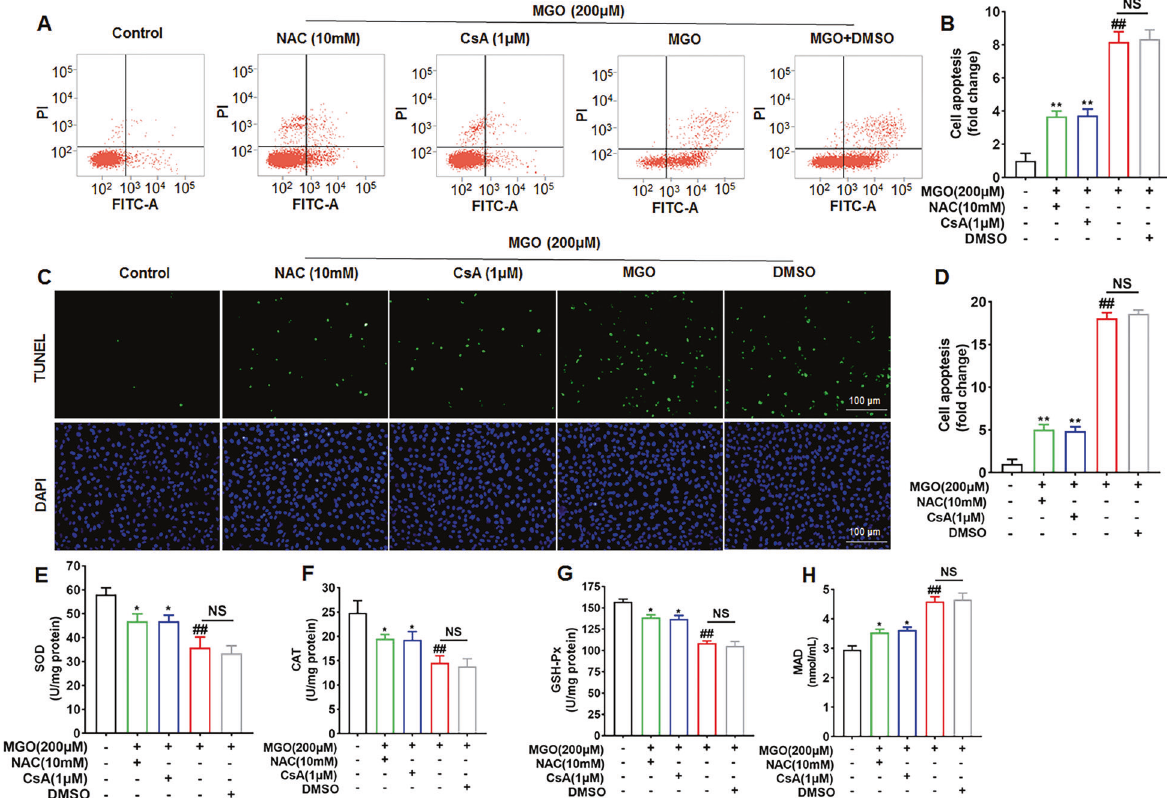
Fig. 3 Effects of NAC and CsA on MGO-induced HUVEC apoptosis. HUVECs were pretreated with NAC (10 mM) and CsA (1 μ M) for 2 h, followed by stimulation with MGO for 24 h. A , B Cell apoptosis was analyzed by fl ow cytometry based on Annexin V-FITC and PI double staining. C , D Cell apoptosis was examined by TUNEL assays. Scale bars, 100 μ m. Representative images of cell apoptosis are shown. E – H The levels of SOD, CAT, GSH-Px, and MAD were measured with the respective kits according to the manufacturer ’ s instructions. The values (mean ± SD from three independent experiments) are relative to the control and are expressed as fold changes. ## p < 0.01 vs. Control, * p < 0.05 vs. MGO, ** p < 0.01 vs. MGO. tary Fig. S3D, E. ML385 notably inhibited the protective effect of MET on MGO-induced HUVEC apoptosis. The above results indicate that the protective effects of MET against MGO-induced cell apoptosis are partly mediated through the PI3K/Akt and Nrf2/ HO-1 signaling pathways.